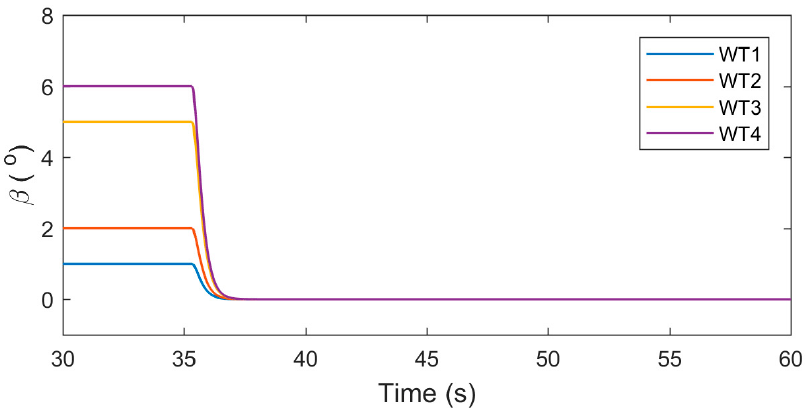
Figure 20. Rotor speed (wind farm).